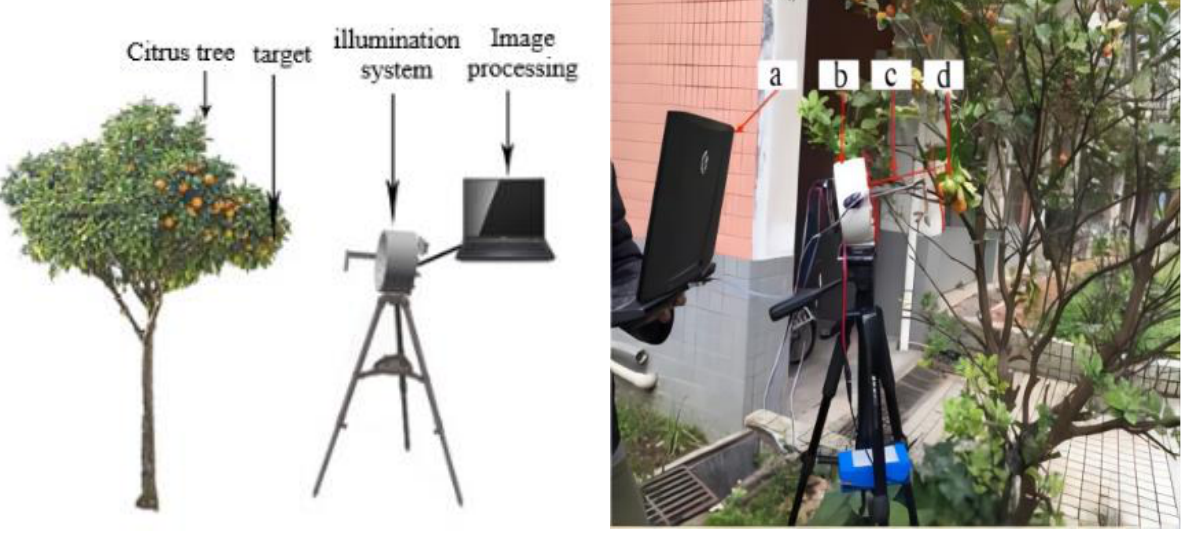
Figure 4. Image acquiring scene. a. PC for visual processing, b. Light vision system, c. Shooting distance, d. The target of citrus.